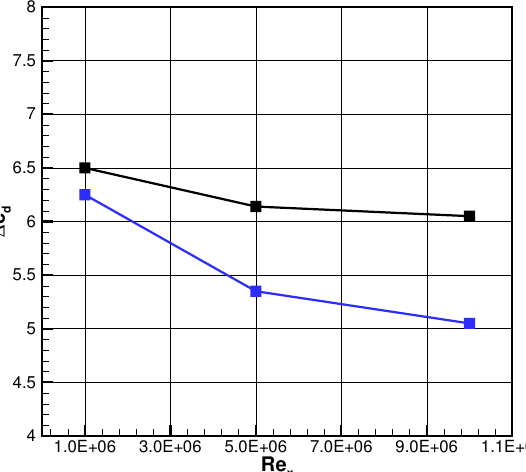
Figure 5. Drag reduction vs. Reynolds number. Blue: Equation (6), black: Equation